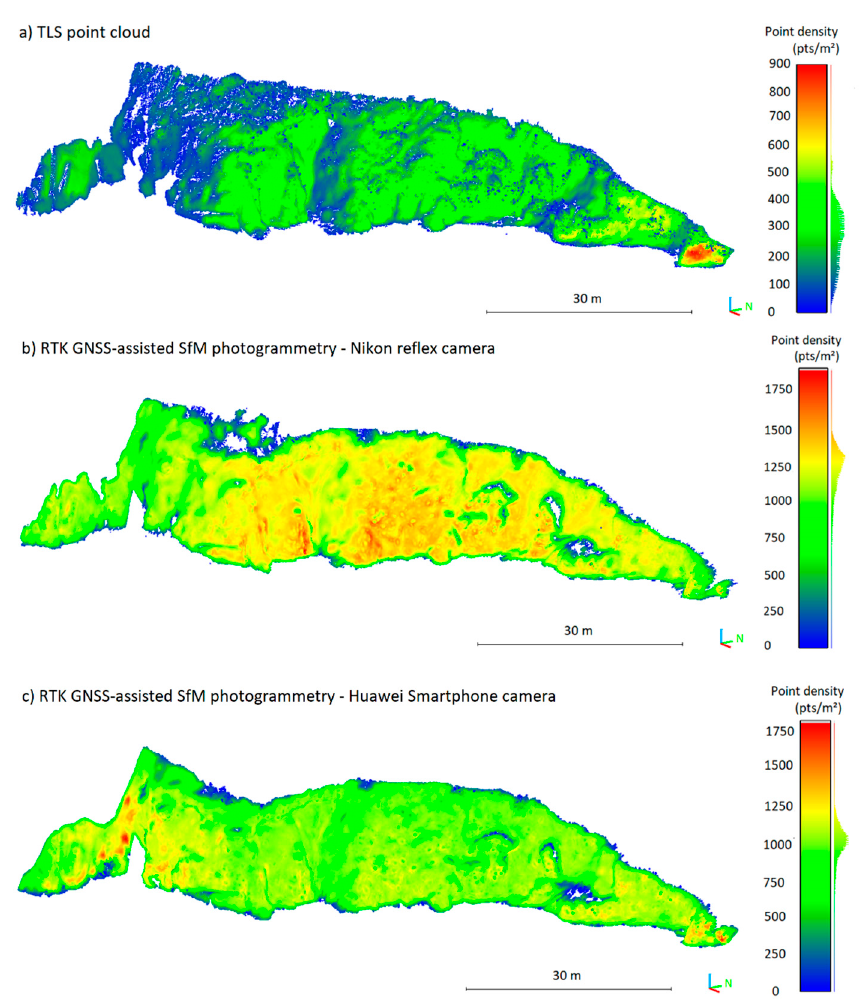
Figure 6. Comparison of point density for the TLS point cloud ( a ) and RTK-GNSS assisted SfM dense point clouds obtained respectively with Nikon Reflex camera ( b ) and Huawei Y5 Smartphone camera ( c ). The colormap was adjusted in the case of the TLS point cloud for the sake of clarity. Table 4. Cloud-to-mesh distances between the TLS mesh (used as reference) and RTK-GNSS assisted SfM dense point clouds.